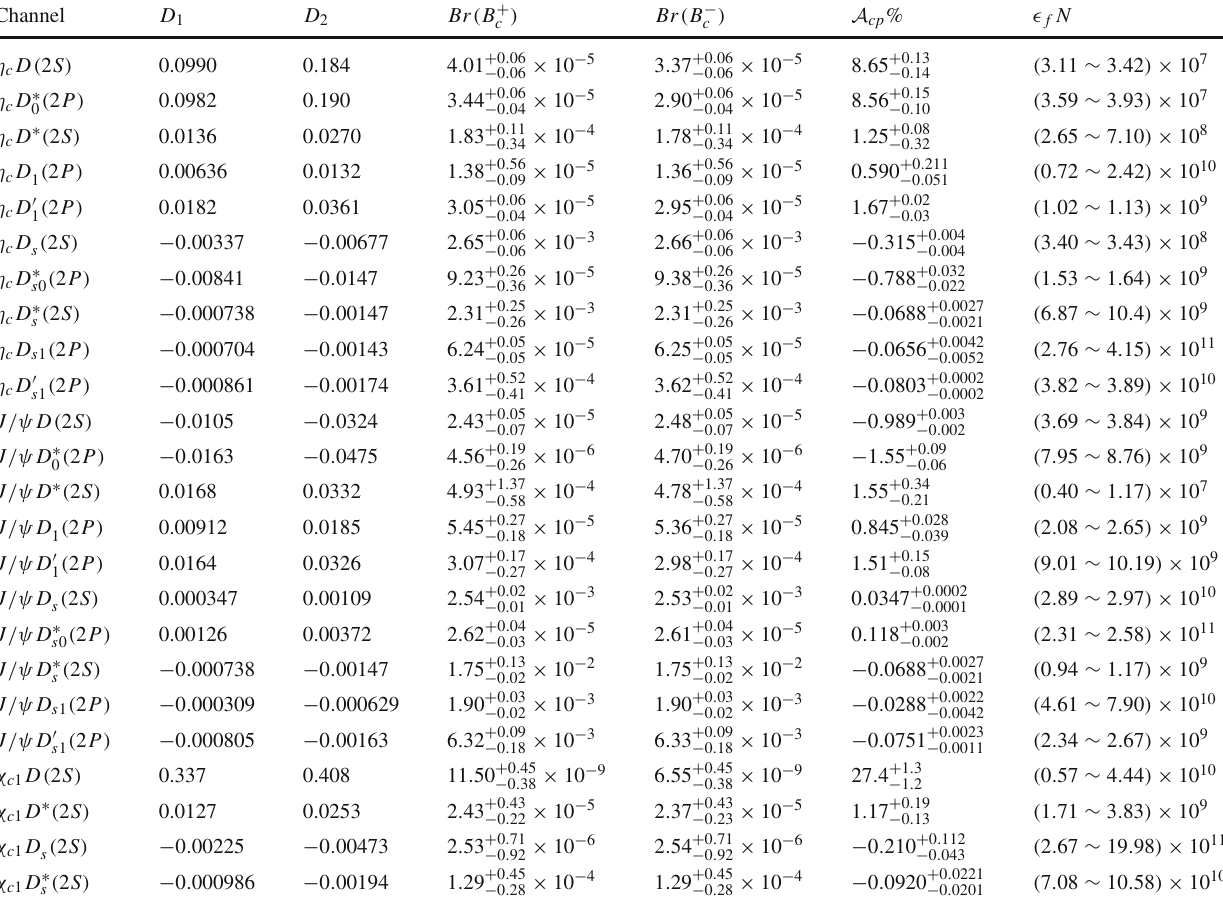
Table 4 The results for B c → c ¯ c ( 1 S ) + ¯ cq ( 2 S , 2 P ) and B c → c ¯ c ( 1 P ) + ¯ cq ( 2 S )